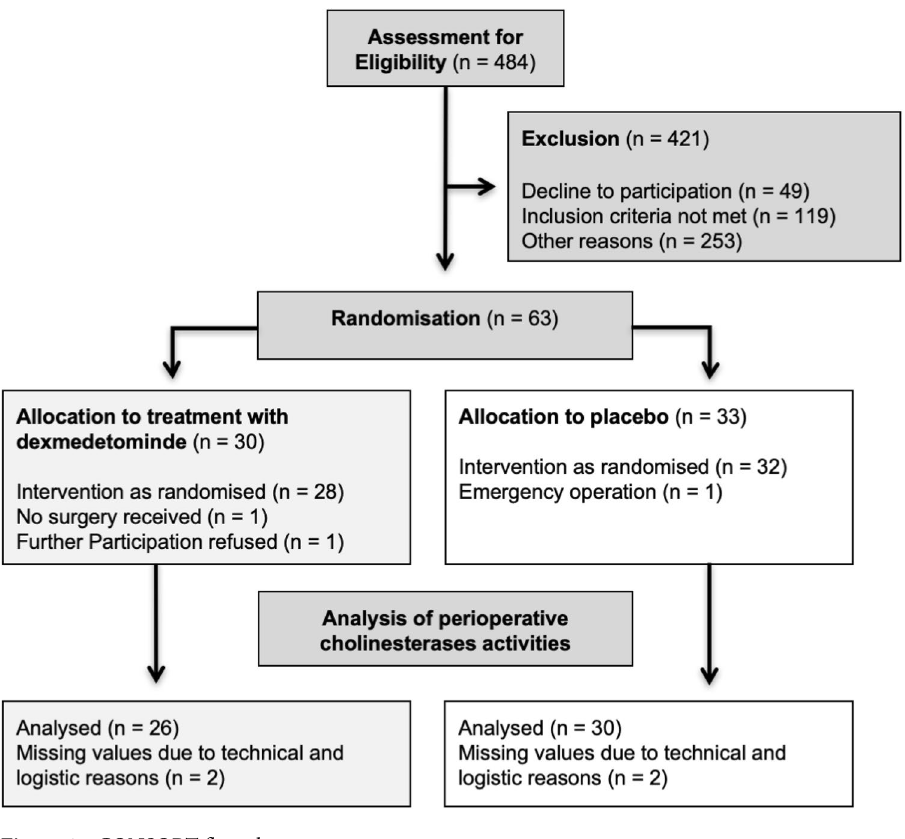
Figure 1. CONSORT flow